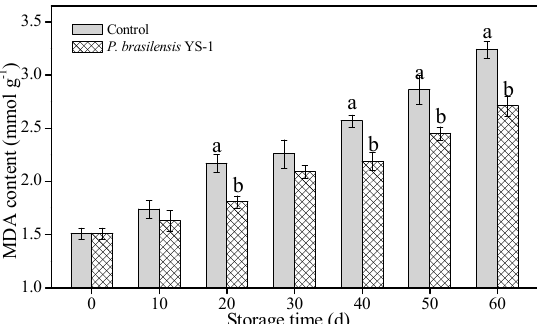
Figure 4. Effect of P. brasilensis YS-1 treatment on the malondialdehyde (MDA) content of citrus fruits stored at 5 ± 0.5 °C for 60 d. Vertical bars represent the mean ± SE (n = 3). Letters indicate statistical differences according to an independent samples t -test ( p < 0.05) on each storage day.